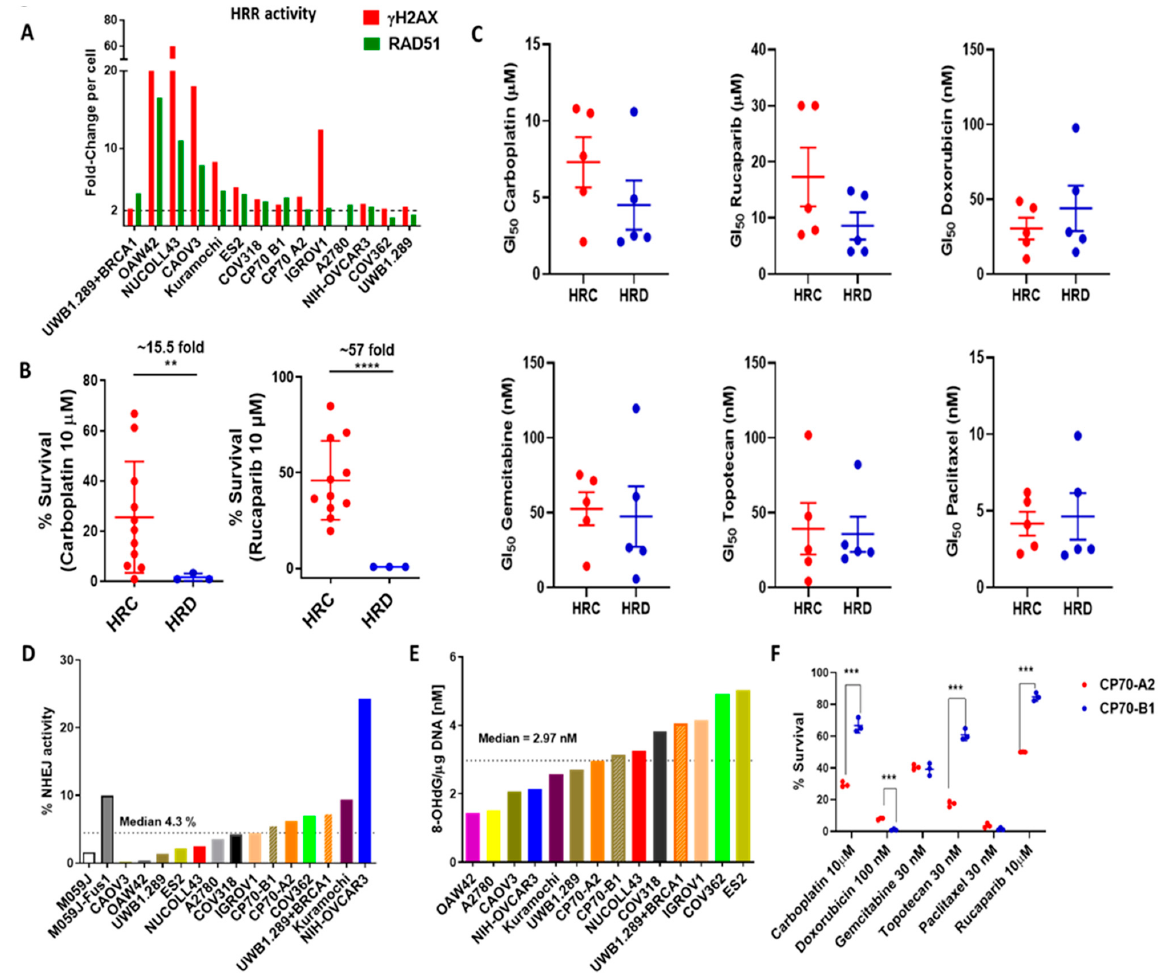
Figure 5. Functional/activation status of the DDR pathway and their association with chemotherapy response in cell lines. ( A ) Homologous recombination repair status of cell lines as determined by γ H2AX-RAD51 foci formation assay. A >2-fold increase in RAD51 foci (green) formation is indicative of functional HRR following DNA damage induction measured by γ H2AX-foci (red), identifying COV362 and UWB1.289 cell lines as HRD. Due to the pan-nuclear staining of γ H2AX in the A2780 cell line, the γ H2AX-foci could not be measured. Data are from a single representative experiment with a minimum count of 100 cells per cell line. ( B ) HRD cell lines were statistically significantly more sensitive to carboplatin and rucaparib. Each data point represents mean % survival at a given concentration of technical replicates of three independent experiments. ( C ) HRD primary cultures were more sensitive to carboplatin and rucaparib while HRC primary cultures were more sensitive to doxorubicin (statistically non-significant) as seen by the difference in the mean in GI 50 values determined by Sulforhodamine B (SRB) assay, each data point represents a single patient-derived primary culture ( D ) %NHEJ activity measured by plasmid re-joining assay. Data represent the mean value of duplicate technical experiments. ( E ) Baseline 8-OHdG/ μ g DNA (nM) for each cell line and its correlation with % survival with each drug at a given concentration. Data represent the mean value of duplicate technical experiments. ( F ) The MMR-deficient cell line CP70-A2 was significantly more sensitive to carboplatin, topotecan, and rucaparib and less sensitive to doxorubicin than CP70-B1 cell line. Each data point represents mean % survival at given concentration of technical replicates of three independent experiments (** p -val < 0.01; *** p -val < 0.001).